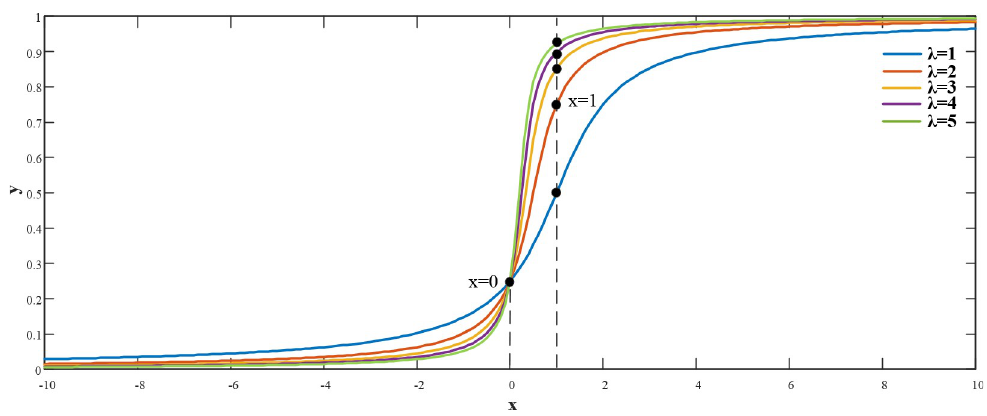
Fig 8. γ function with different λ values.